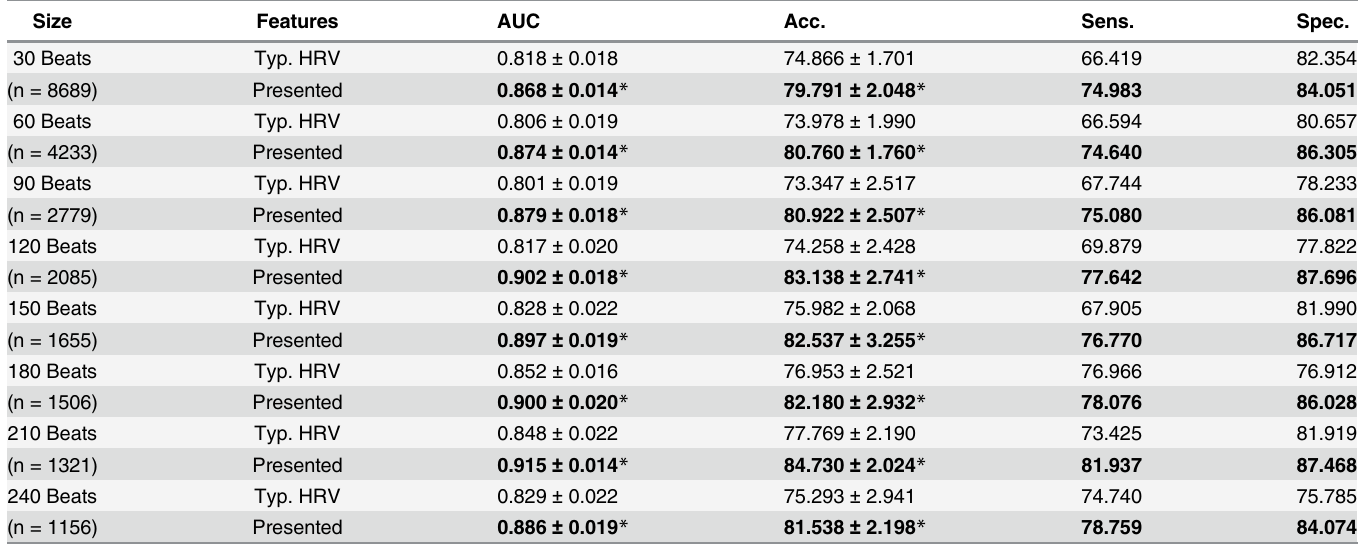
Table 2. Prediction Model Comparison Table — The table compares the AUC, accuracy, sensitivity and specificity of the typical HRV features and the presented features for different window sizes as well as the 95% confidence intervals for the AUC and accuracy values. Asterisks indicate statis- tical significance at the α = 0.01 level. Bold indicates best score for that feature set. A non-parametric Mann-Whitney U test was used. The number of instances is denoted by n for each feature set. Size